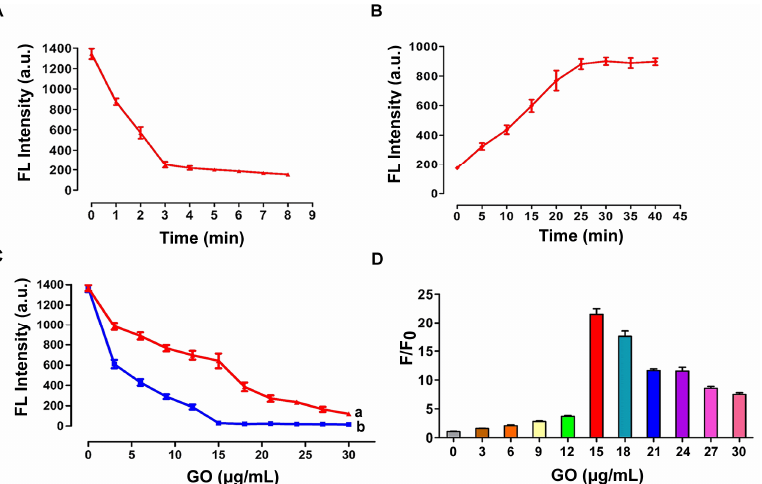
Figure 3. ( A ) Time dependence of the fluorescence quenching degree for 200 nM FAM-W3 caused by GO. ( B ) Time dependence of the fluorescence recovery degree for FAM-W3 in GO